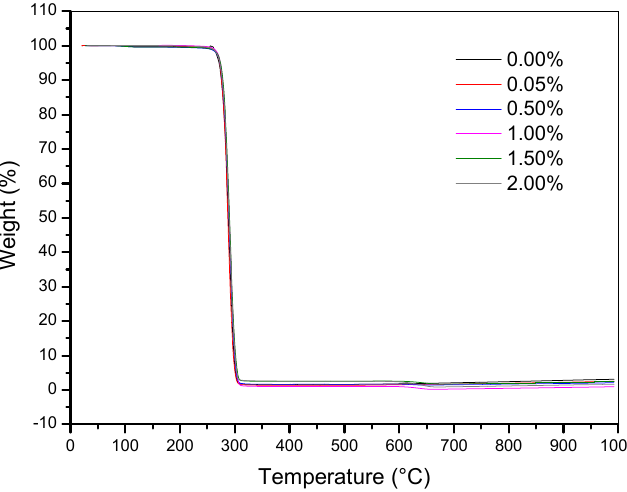
Figure 4. Thermogravimetric curves of neat PHBV and nanocomposites.